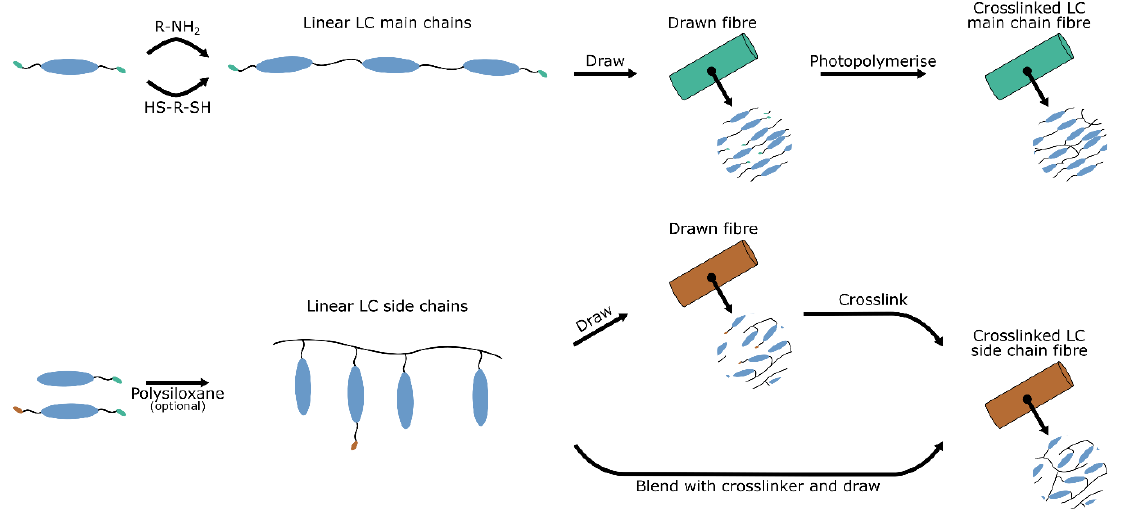
Figure 3. Schematic illustration of the preparation of main chain LC fibres (top scheme), and side chain LC fibres (bottom scheme). In both cases, LC monomers are extended into short (LC oligomer) or long (LC polymer) chains to increase the material viscosity. The viscous material is then drawn into a fibre and crosslinked to yield the final LC fibre.